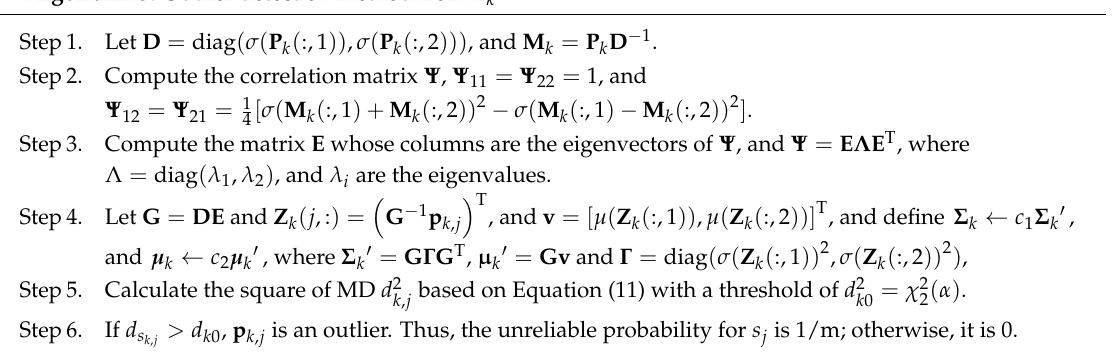
Algorithm 3. Outlier detection method from P k